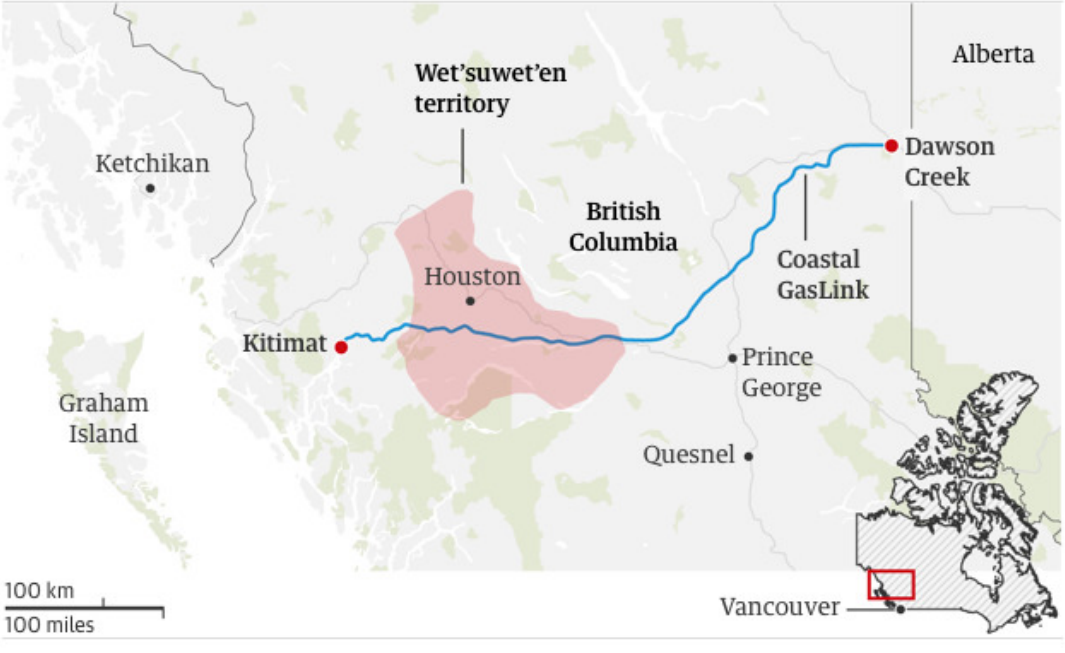
Figure 1: The Guardian ’s Wet’suwet’en map. Source: https://www.theguardian.com/world/2019/dec/20/canada-indigenous-land-defenders-police-documents. Image reproduced under the Fair Use